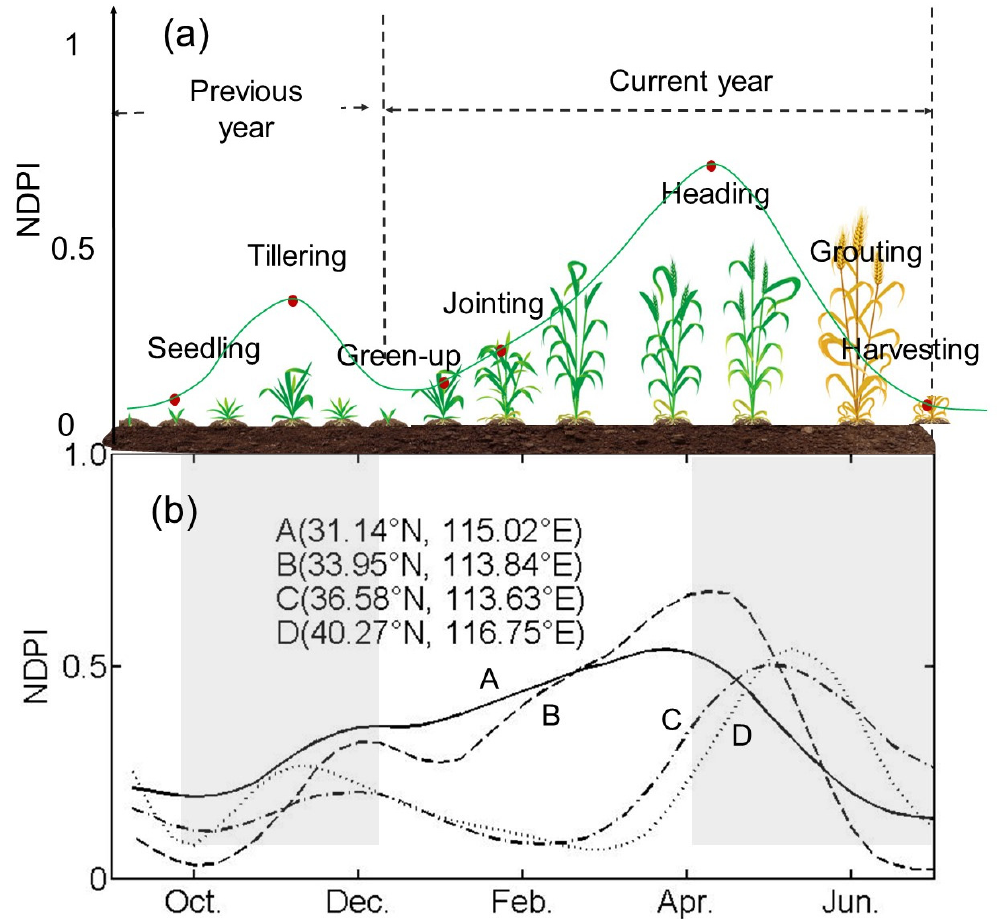
Figure 1. ( a ) Normalized di ff erential phenology index (NDPI) [18] curves and the corresponding phenological stages of winter wheat. ( b ) NDPI curves of winter wheat from di ff erent locations in North China. NDPI curves in ( a , b ) are derived from sentinel-2 MSI data. Curve D is from a location of a rotation of winter wheat and summer